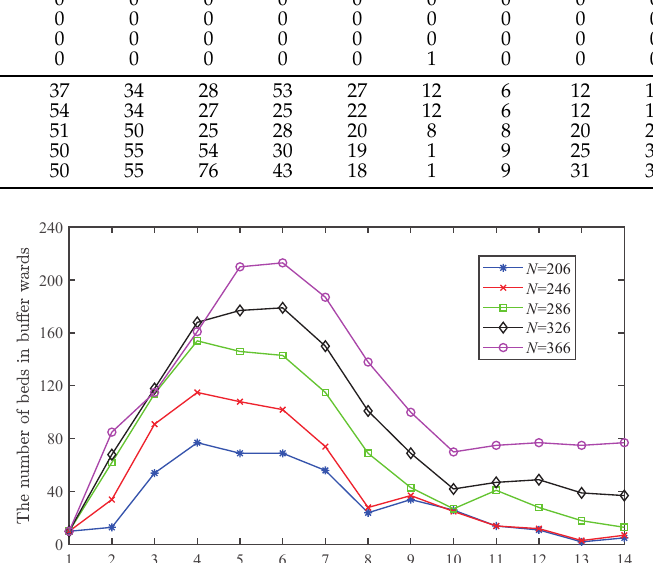
Figure 7. The number of beds in buffer wards in case 1.